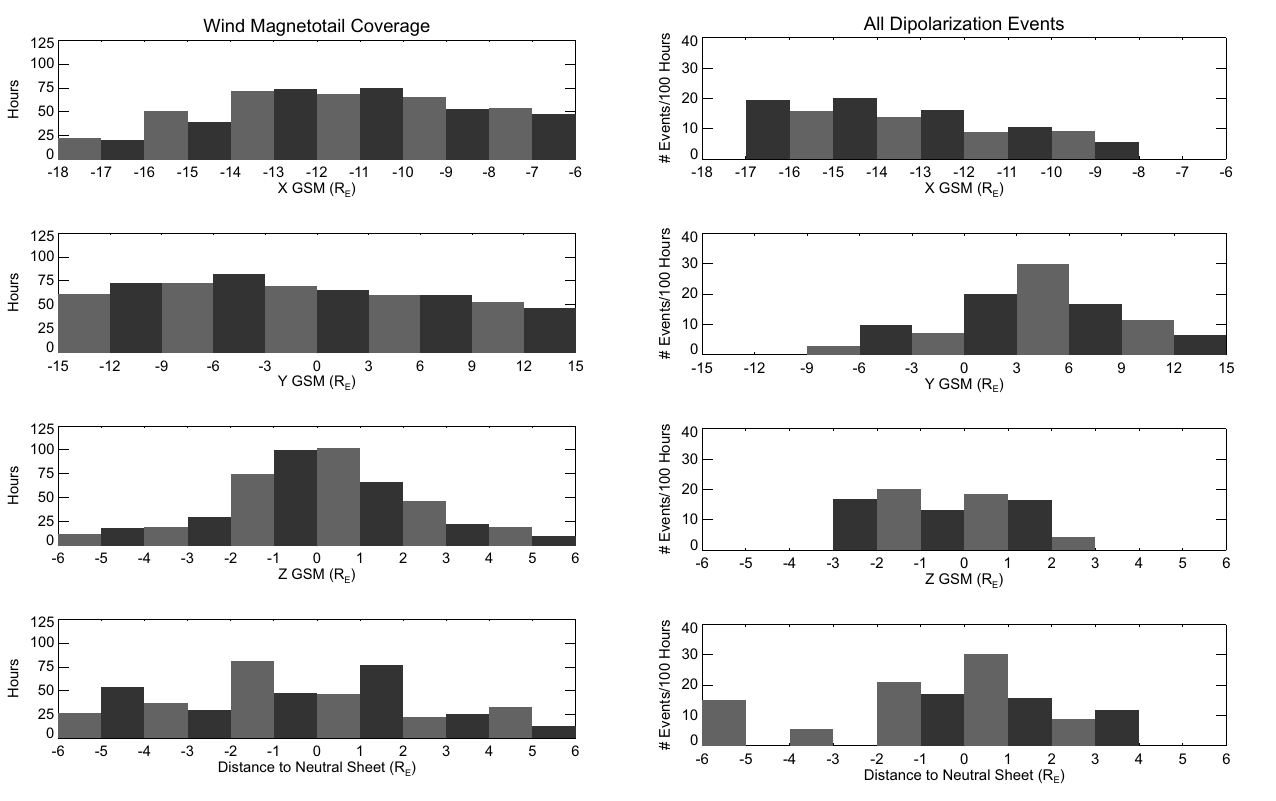
Fig. 7. Histograms of the number of dipolarization events per 100h observed by Wind in the same position bins shown in Fig. 6. termined by Fairfield (1980). The Wind spacecraft spent the most time in the magnetotail between − 6 <X< − 14 R E . The passes through the magnetotail were fairly evenly dis- tributed across the tail in the Y direction, but Wind spent slightly more time in the post-midnight region ( Y< 0) than it did in the pre-midnight region. Wind was generally lo- cated between − 2 <Z< 3 R E , but there was a much broader distribution of positions relative to the Fairfield (1980) neu- tral sheet, as shown in Figure 6. Seasonal effects caused by the Earth’s dipole tilt were taken into account when calculat- ing the neutral sheet model and the position of Wind relative to the neutral sheet. Figure 7 shows a histogram of the number of dipolariza- tion events per 100 h observed by Wind in the position bins from Fig. 6. Dipolarization events were observed by Wind between − 8 <X< − 17 R E . More dipolarization events were observed further away from Earth, in agreement with results from AMPTE/CCE (Lopez et al., 1988). Although Wind spent more time in the post-midnight region of the magne- totail, the distribution of dipolarization events was peaked in the pre-midnight region ( Y> 0), confirming the results of the Lopez et al. (1988) dipolarization study. The dipo- larization events were all observed between − 3 <Z< 3 R E , and most occurred within a few R E of the Fairfield (1980) neutral